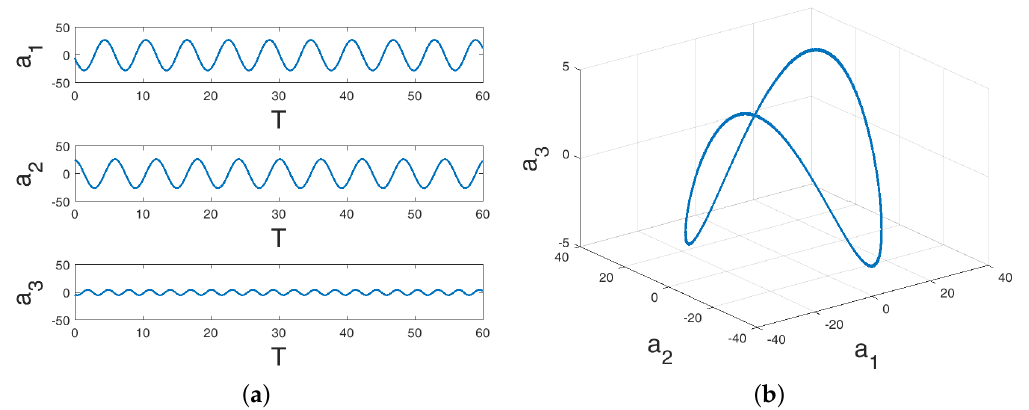
Figure 5. The temporal evolution of the first three normalized proper orthogonal decomposition (POD) coefficients for limit cycle cylinder flow at Re = 100. ( a ) 2D view; ( b ) 3D